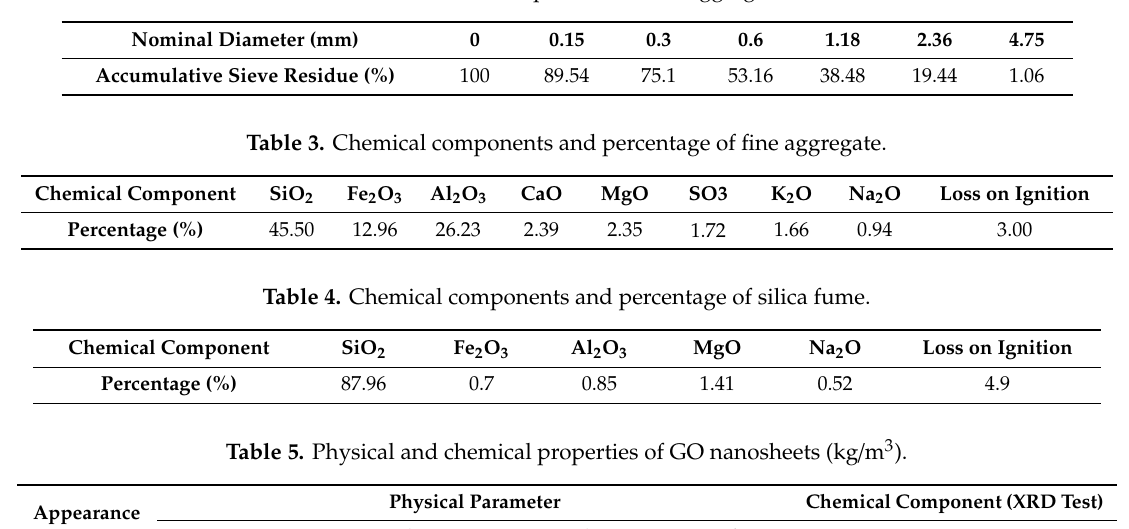
Table 2. Grain composition of fine aggregate.